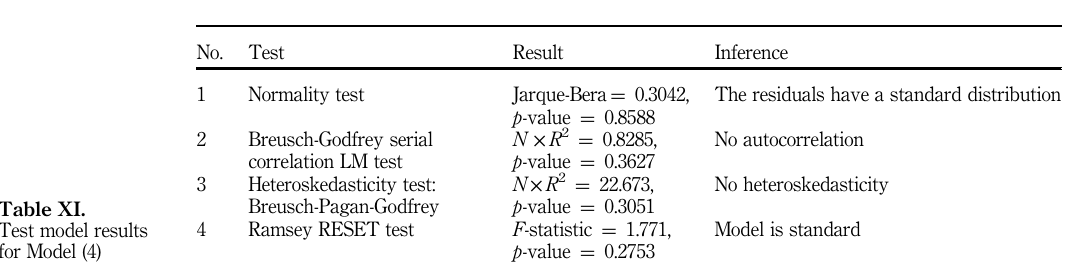
Table X. Estimating the ARDL model with dependent variable LNIP (Model 4)